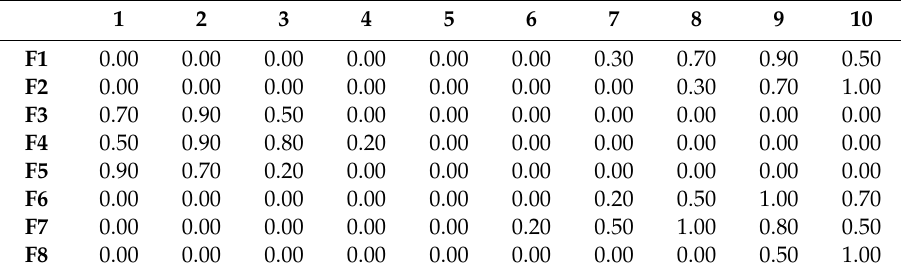
Table 12. Expert #4 favorable evidence degree versus VMEA weights.